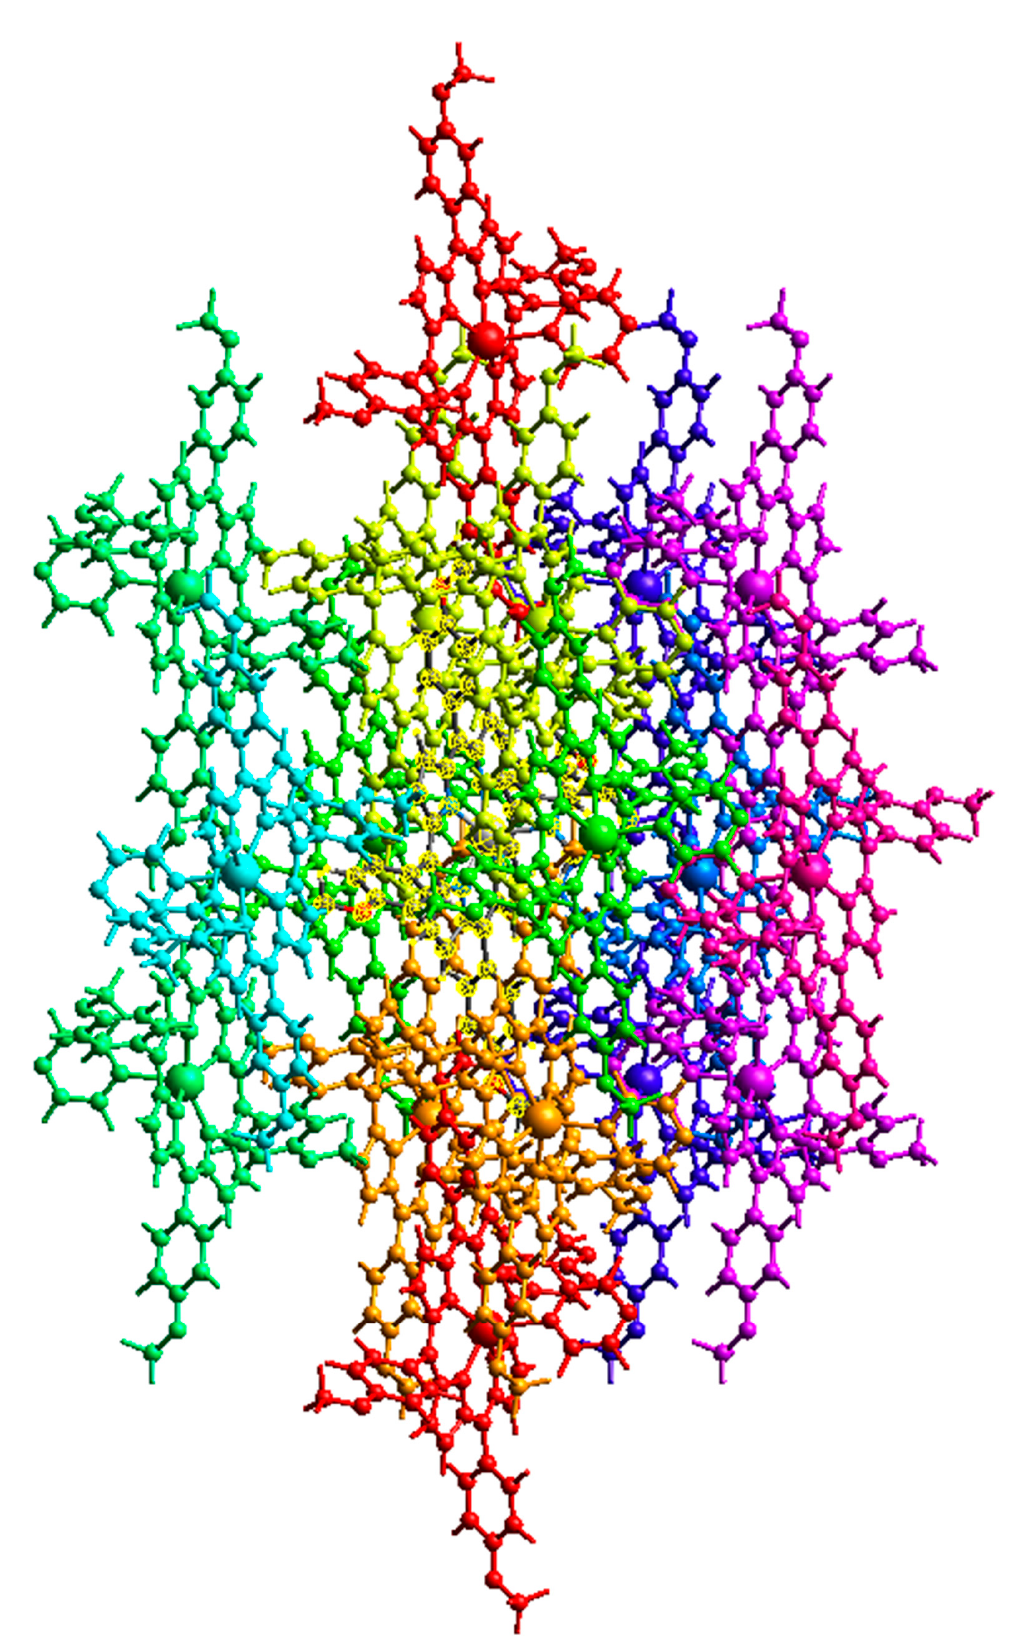
Figure 6. Intermolecular interaction energies between neighbouring Cd-TMPP-Pyz molecules. The normalized contact distance (d norm ) consisting of d e and d i is denoted by d norm = d i - 𝑟 (cid:3036)(cid:3049)(cid:3031)(cid:3050) / 𝑟 (cid:3036)(cid:3049)(cid:3031)(cid:3050) (cid:3397) d e - 𝑟 (cid:3032)(cid:3049)(cid:3031)(cid:3050) / 𝑟 (cid:3032)(cid:3049)(cid:3031)(cid:3050) , where 𝑟 (cid:3036)(cid:3049)(cid:3031)(cid:3050) and 𝑟 (cid:3032)(cid:3049)(cid:3031)(cid:3050) are the van der Waals radii of the atoms. A negative d norm results in a shorter intermolecular contact than r vdw . Conversely, a